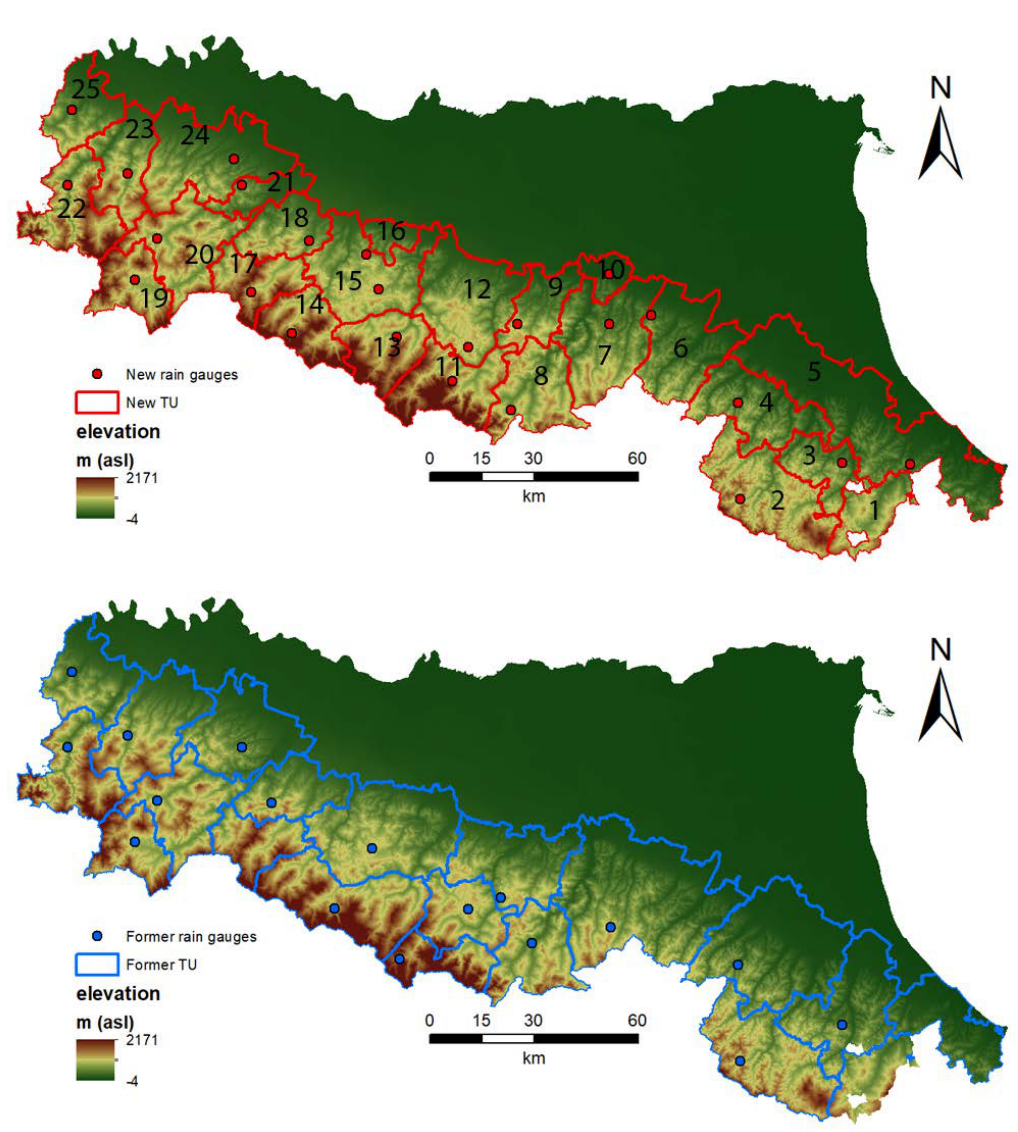
Figure 3. Change in the TU number, boundaries and reference rain gauges.